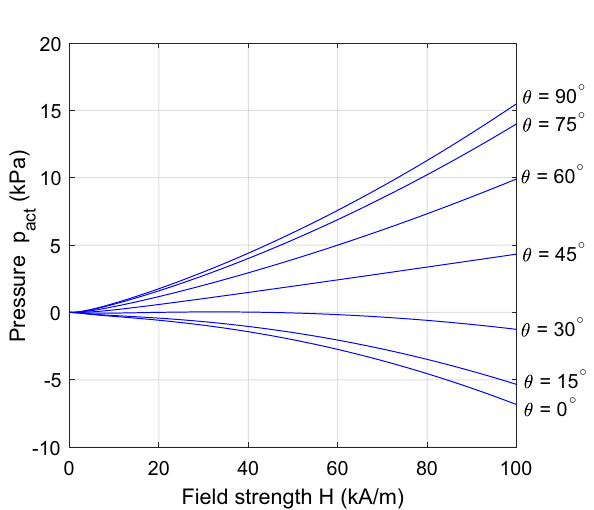
Figure 4. Dependency of transmitted pressure p act on field strength for different field directions θ when magnetization saturation is accounted